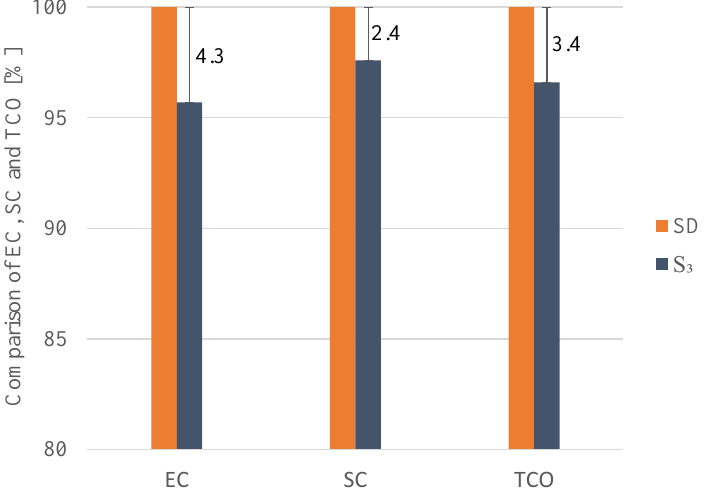
Figure 17. Comparison of normalized EC, SC and TCO between SD (with a total vehicle mass of 1677 kg) and S 3 , where EC represents the energy consumption and SC the system